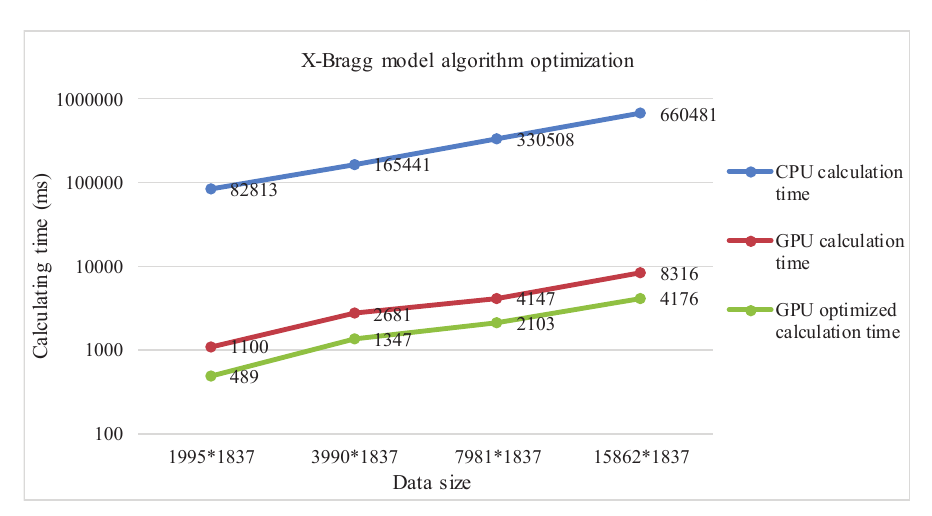
Figure 10. Acceleration performance comparison of the X-Bragg algorithm.